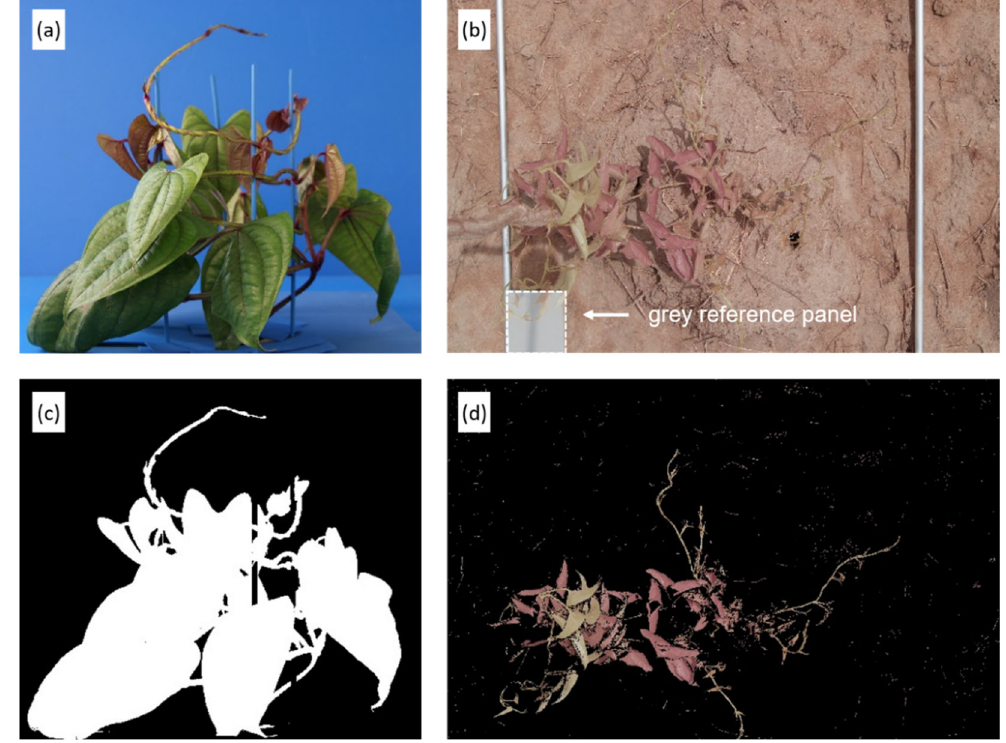
Figure 3. ( a ) Side view image of a yam plant in the indoor imaging platform; ( b ) nadir image from the field imaging platform and the corresponding segmented images ( c , d ), respectively.